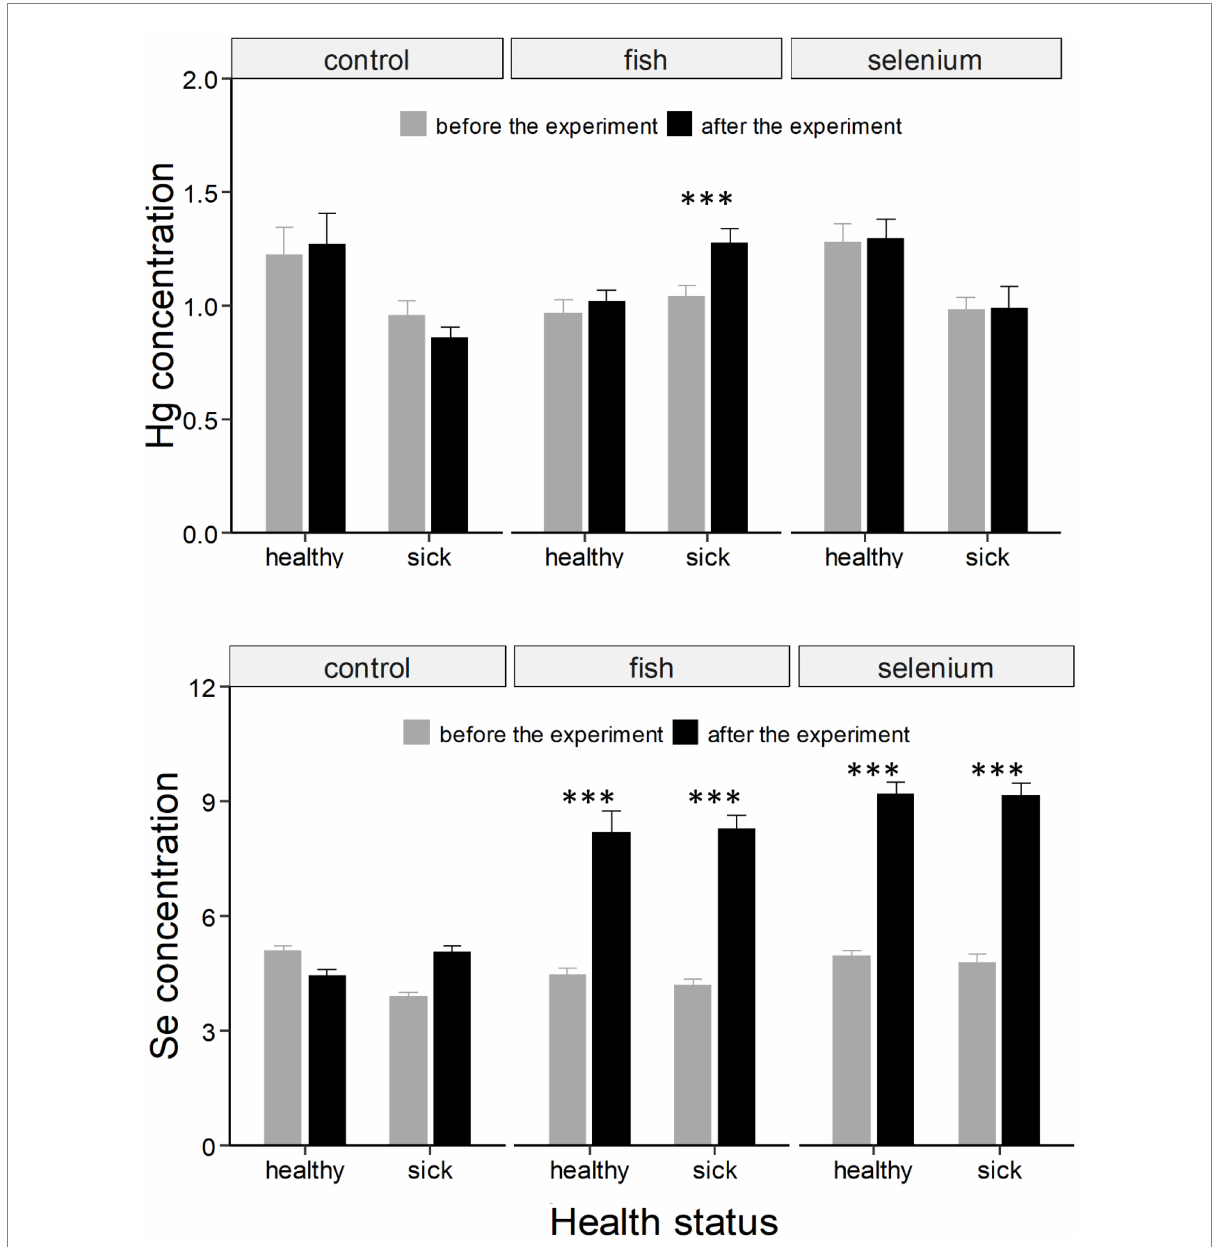
FIGURE 1 Hg and Se concentrations (expressed as μ g g − 1 dry weight ± SE) in chicks divided based on the health status and experimental group (control, fish supplemented, or Se supplemented). Asterisks * indicate a significant change in concentrations from “before the experiment” (grey column) to “after the experiment” (black column). ***, indicates a value of p <